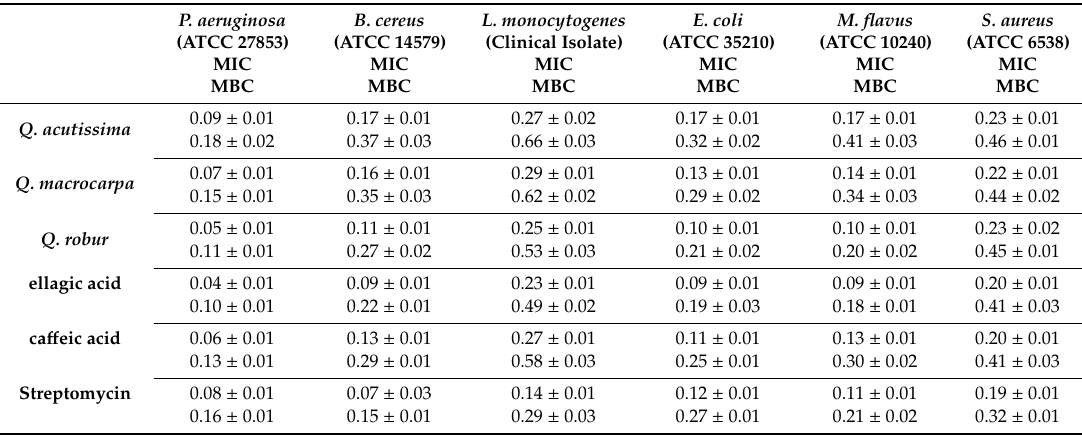
Table 3. Minimum inhibitory (MIC) and bactericidal concentration (MBC) of Q. acutissima, Q. macrocarpa and Q. robur outer bark extracts (mg mL − 1 ) as well as phenolic